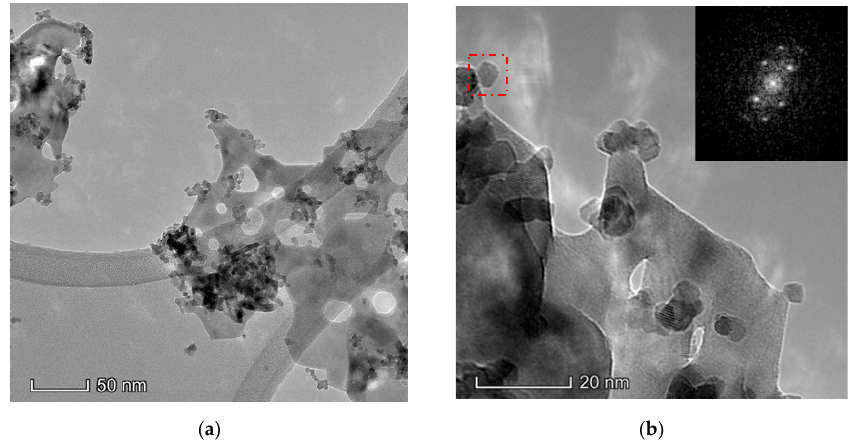
Figure 5. Representative TEM images of the Ni-Ce-8 catalyst: ( a ) low magnification; ( b ) high magnification; and as insets the digital diffractograms (DDPs) of the zone marked.